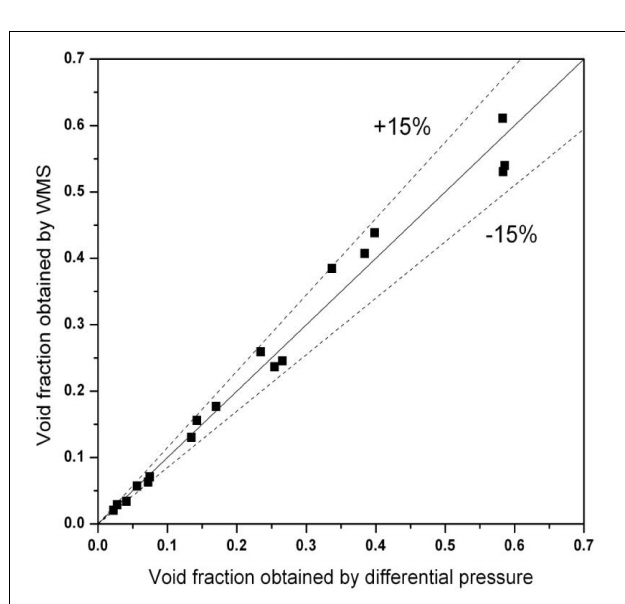
FIGURE 5 | Differential pressure measuring.